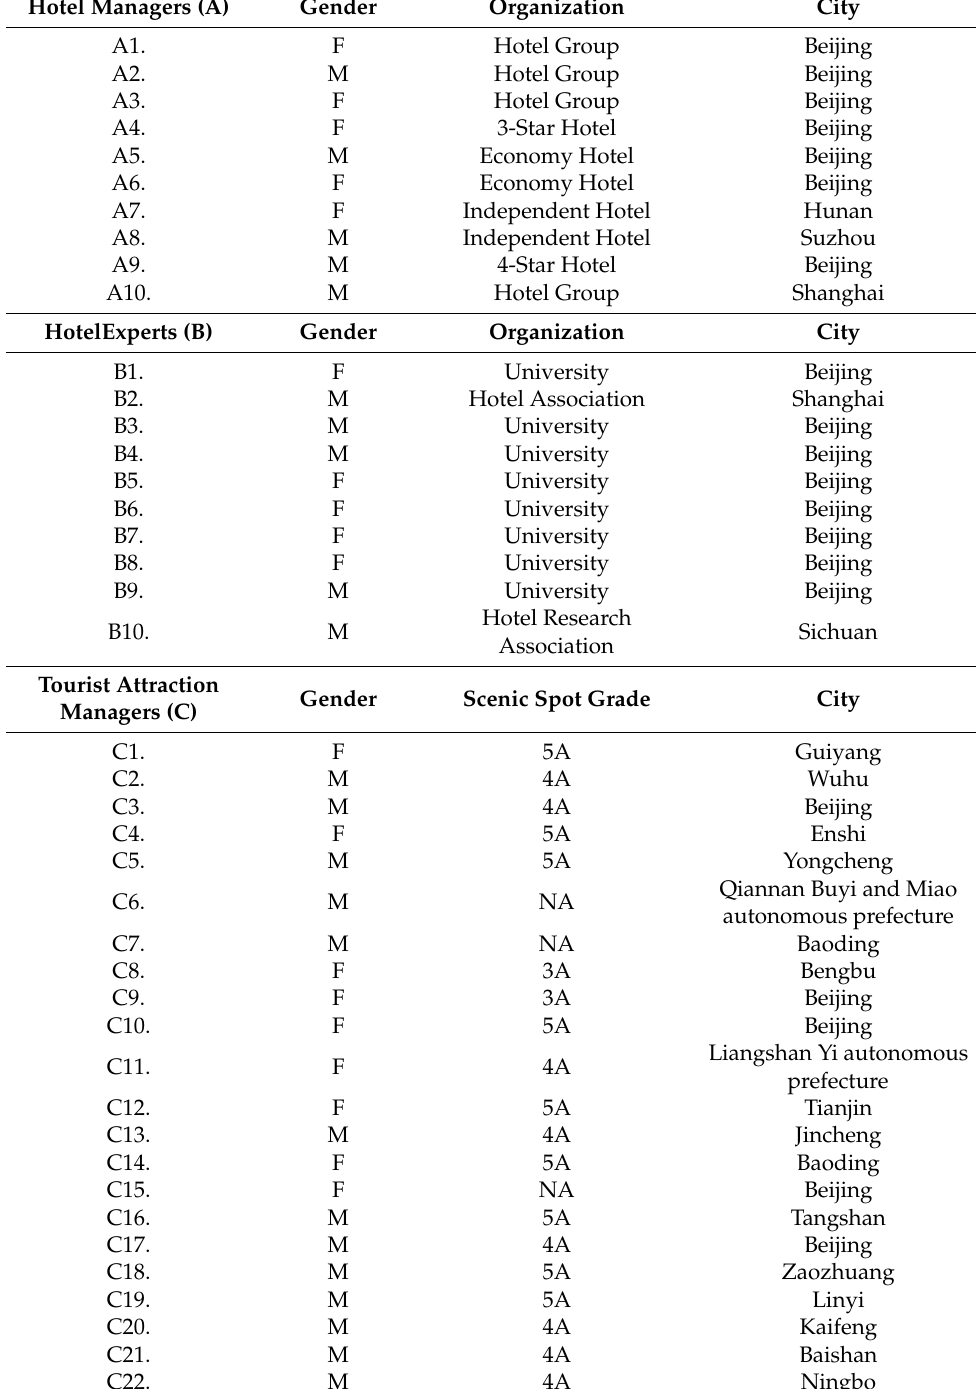
Table 1. Demographic profile of